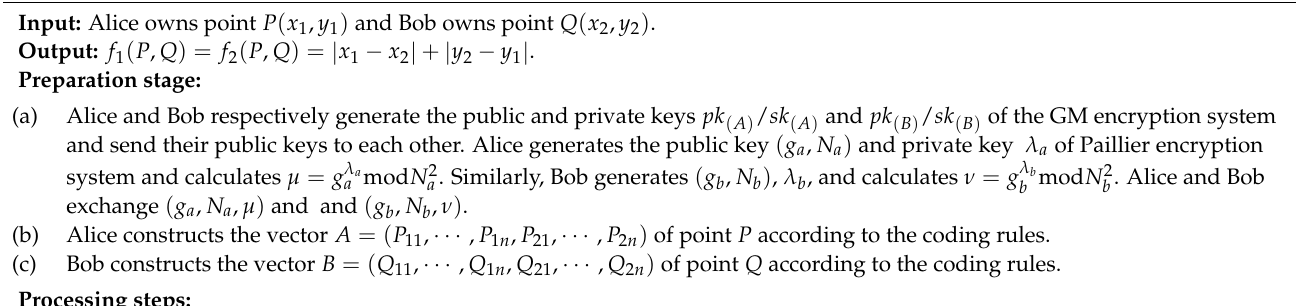
Algorithm 2 Securely computing the Manhattan distance under the malicious